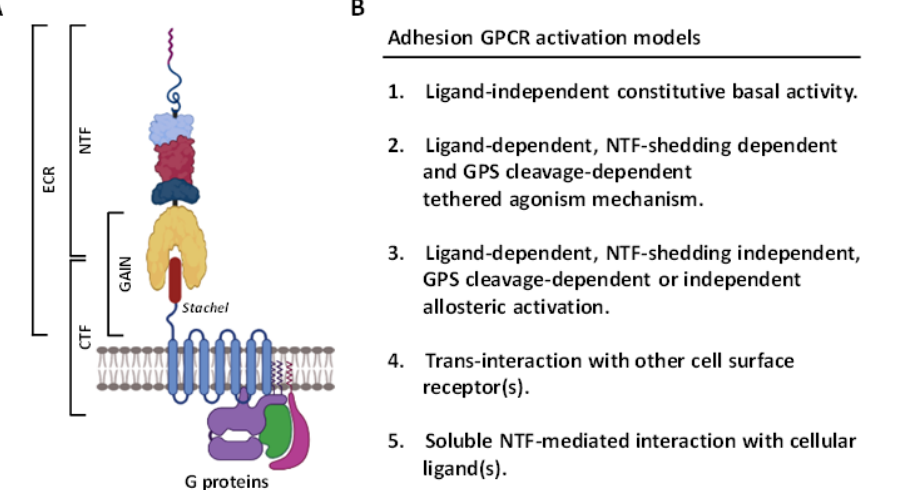
Figure 1. Structural features and activation mechanisms of adhesion GPCRs. ( A ) Schematic depicting the structural organization of aGPCRs in general. The ECR contains multiple cell-adhesive protein domains (indicated by different colored lines and shapes) followed by a GAIN domain. The Stachel peptide is depicted as a brown cylinder. ECR, extracellular region; CTF, C-terminal fragment; NTF, N-terminal fragment; GAIN, GPCR autoproteolysis-inducing. Illustration was generated using the Biorender software. ( B ) The diverse potential activation mechanisms mediated by aGPCRs.